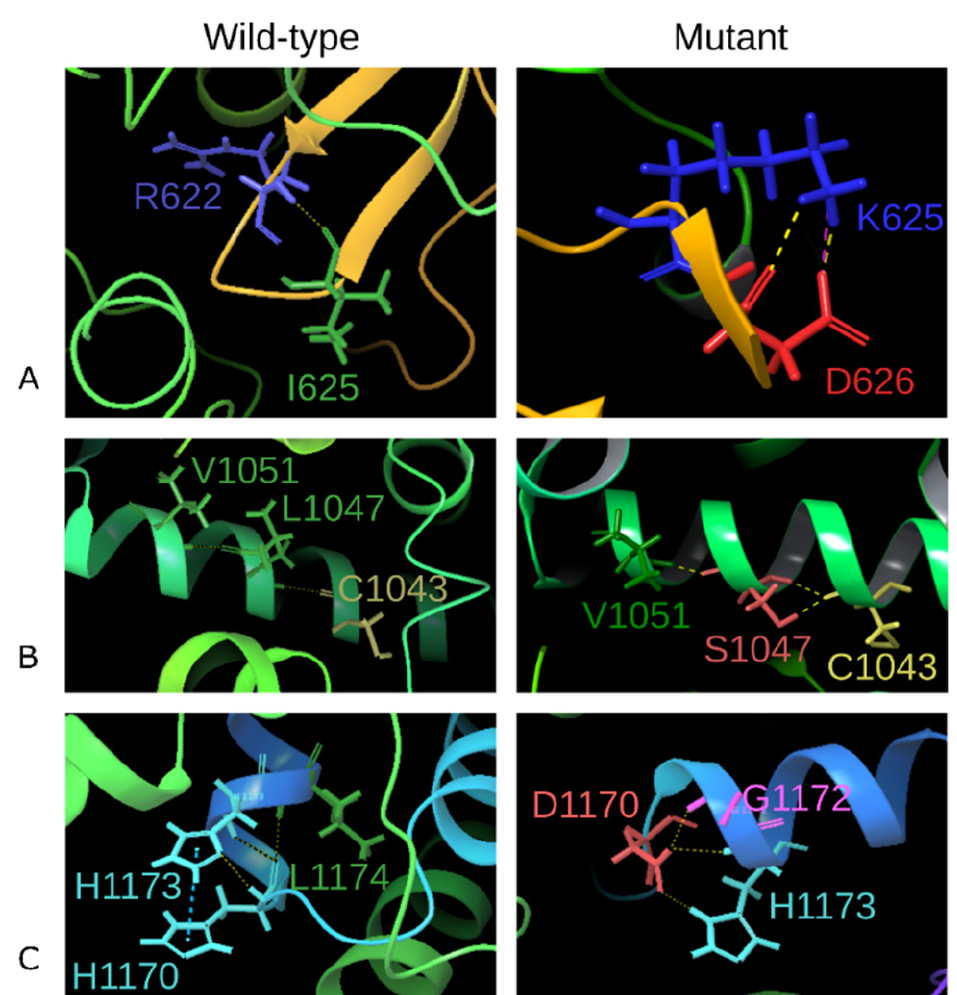
Figure 3. Comparison of interactions formed by the native and mutated protein residues in positions 625 (variant I625K, ( A )), 1047 (L1047S, ( B )), and 1170 (H1170D, ( C )). The residue name and index are demonstrated. The yellow dashed line indicates H-bonds, salt-bridge is colored by magenta, and pi-pi stacking is shown by the blue dashed line.